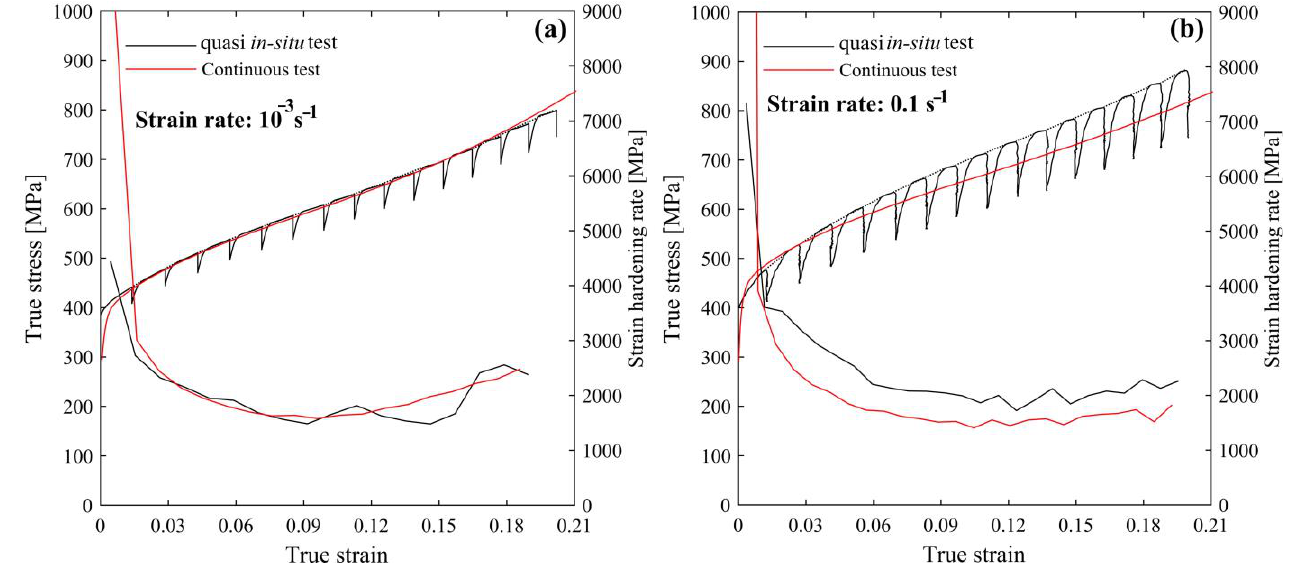
Figure 3. True stress vs. strain curves of the quasi in-situ and continuous tensile tests at nominal strain rates of 10 −3 s −1 and 10 −1 s −1 . The drops in the curves were caused by the stress relaxation that occurred during holding